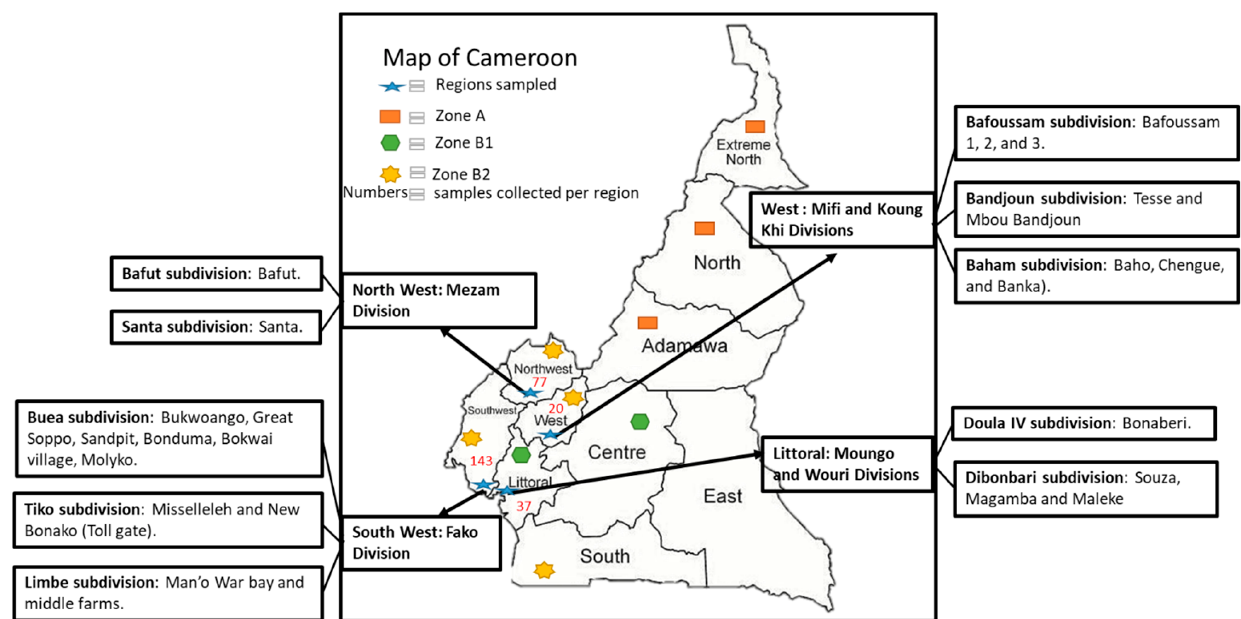
Figure 1. Map of Cameroon showing the Regions, Zonal distributions, number of samples collected per Region, Divisions and Subdivisions sampled as well as the cities or villages sampled within the different subdivisions.